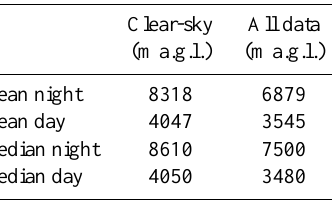
Table 2. Mean and median of the highest point (meters above ground level) in lidar profiles for day and night. Integration time: 30min. Day, night, and clear sky are defined in Sect.